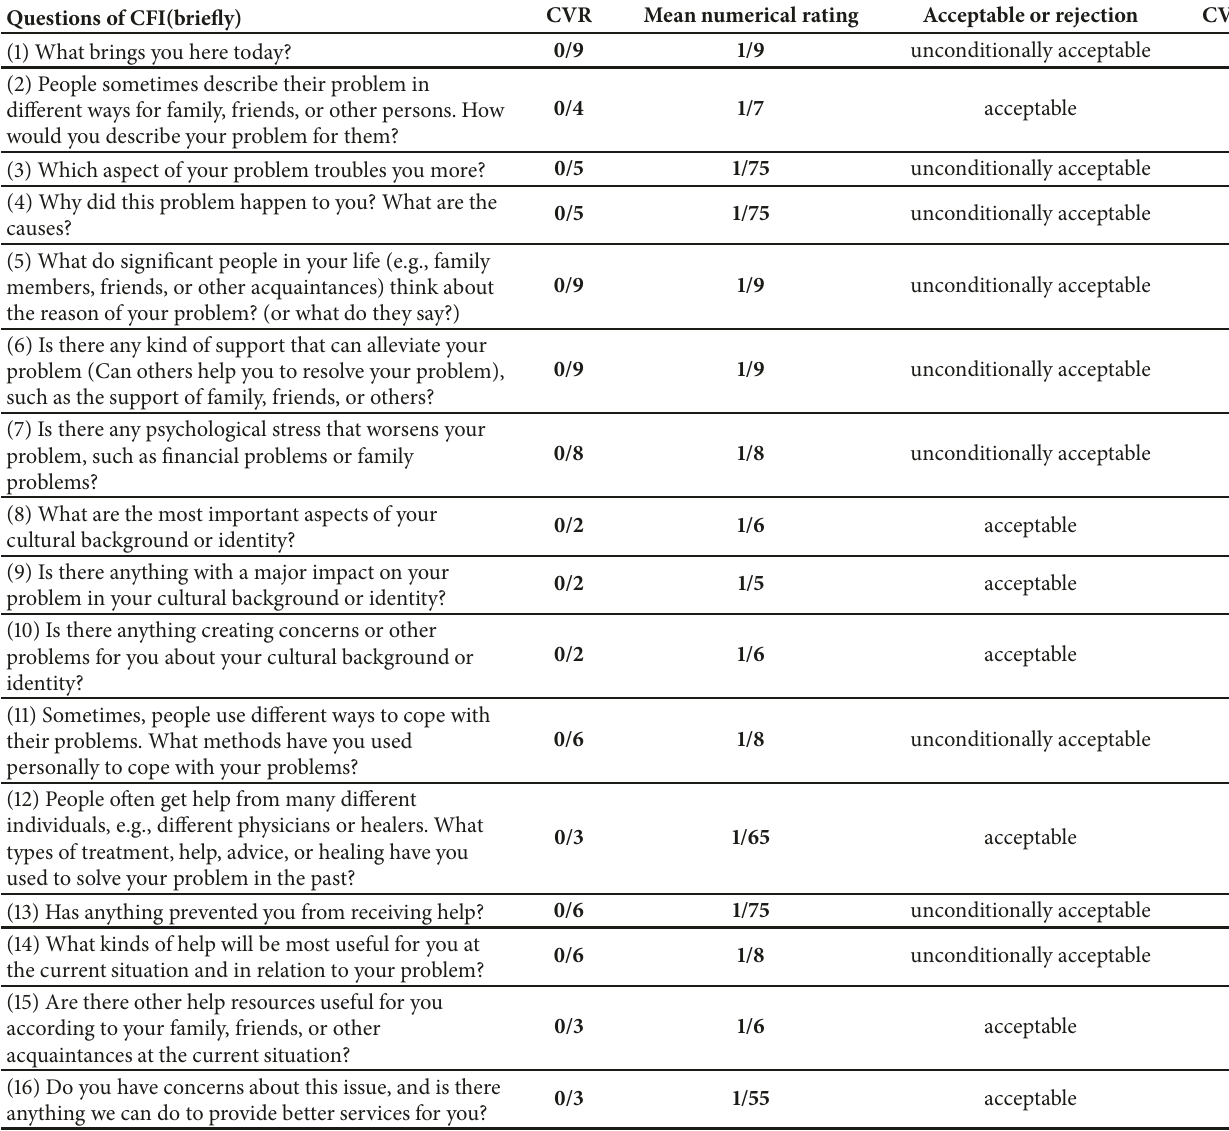
Table 3: CVI and CVR of the Persian version of the Cultural Formulation